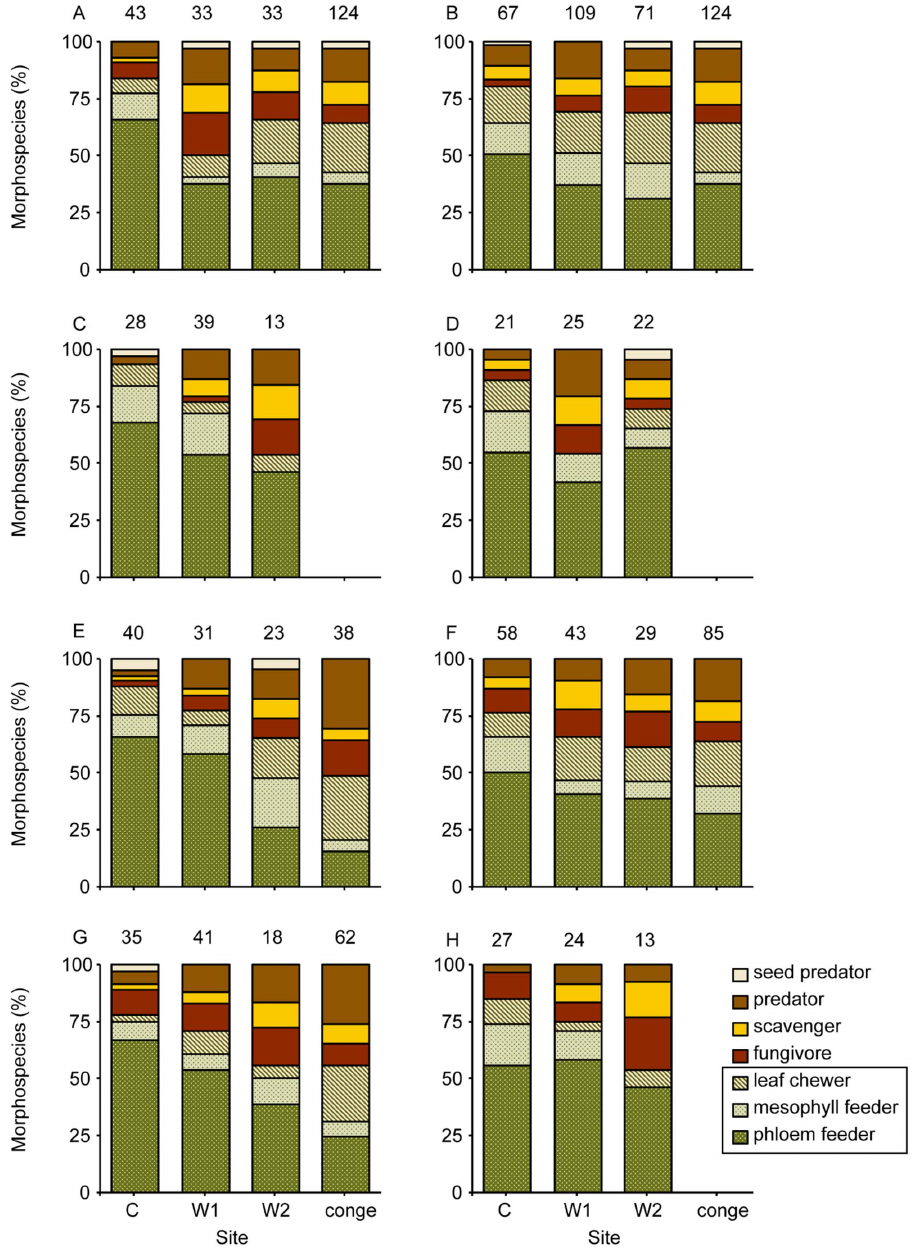
Figure 2. Coleoptera and Hemiptera feeding guild structure from eight plant species at three transplant sites. A. obtusata (A), A. parvipinnula (B), D.corymbosa (C), A. hispida (D), C. pinifolius (E), L. squarrosum (F), H. gibbosa (G) and T.speciosissima (H) at control (C), warm 1 (W1) and warm 2 (W2), and congeneric plant species (conge) at the warm sites. Herbivore feeding guilds are ‘hatched’; mesophyll and phloem feeders combined are ‘sapsuckers’; numbers above bars show number of